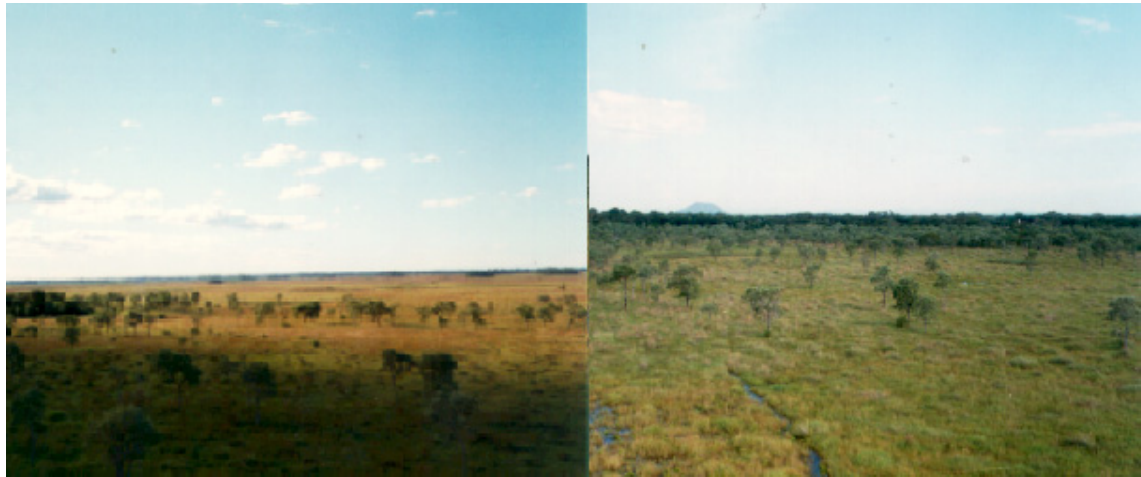
Figure 2. North ( left ) and south ( right ) view from the micrometeorological